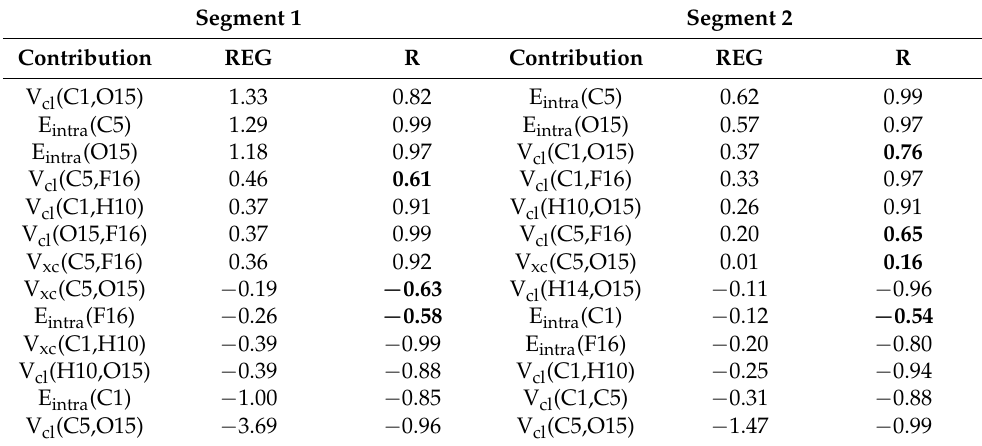
Table 4. REG analysis for the R isomer. Unacceptably low R values are marked in